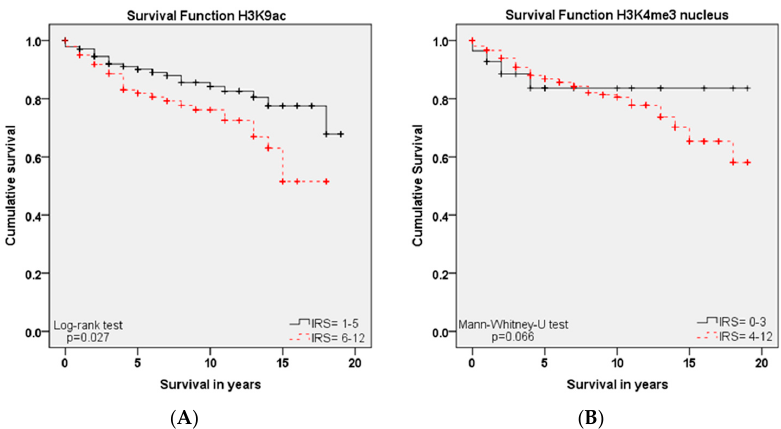
Figure 3. Kaplan–Meier analyses for overall survival: H3K9ac ( p = 0.027; A ) with high expression (IRS ≥ 6; red) compared to low expression (IRS ≤ 5; black); High nuclear H3K4me3 expression (IRS ≥ 4; red) compared to low expression (IRS ≤ 3; black) regarding overall survival ( p = 0.066; B ).